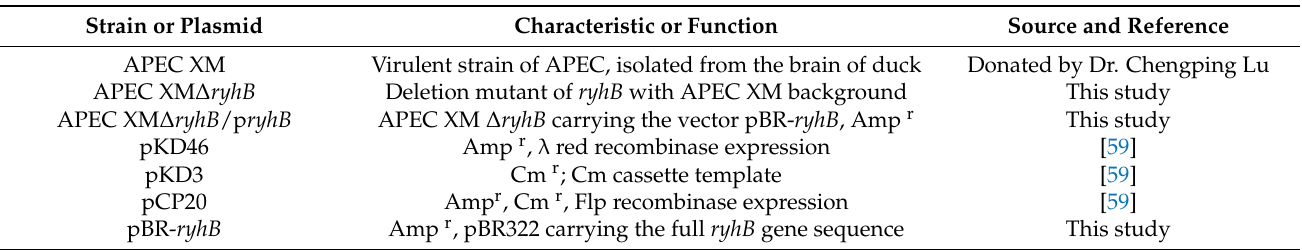
Table 1. Bacterial strains and plasmids used in this